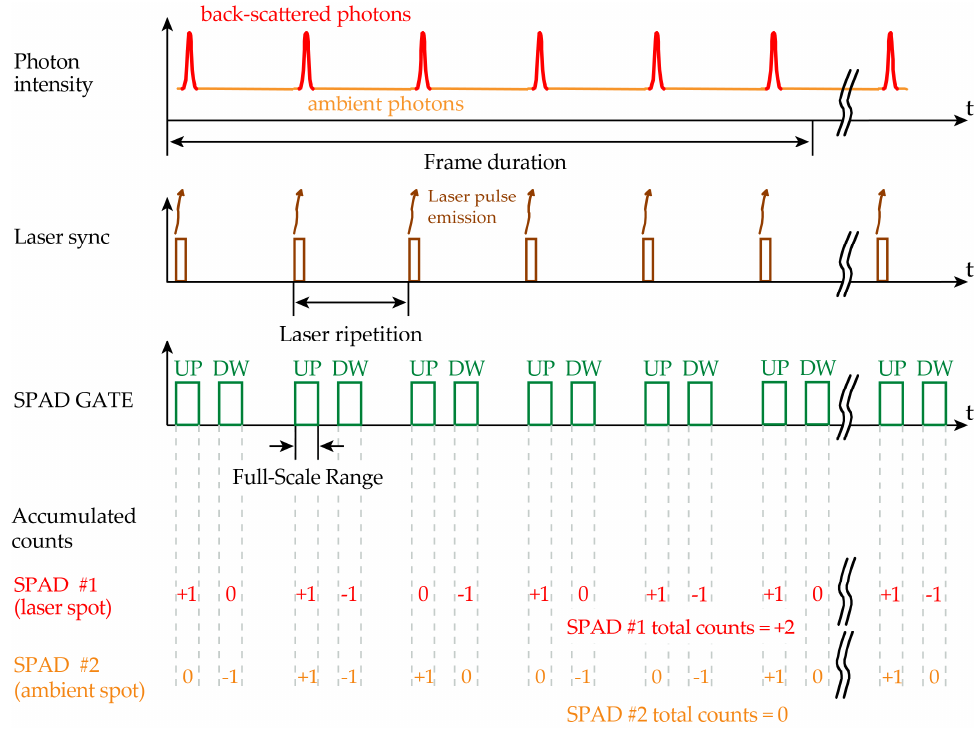
Figure 10. Timing diagram of the signals to properly count ( upwards ) signal and background pho- tons and to subtract ( downwards ) only background photons, during one frame (i.e., 500 laser pulses). Two SPADs are considered, SPAD #1 inside and SPAD #2 outside the laser spot, thus accumulating a total positive count and an average nil count, respectively.